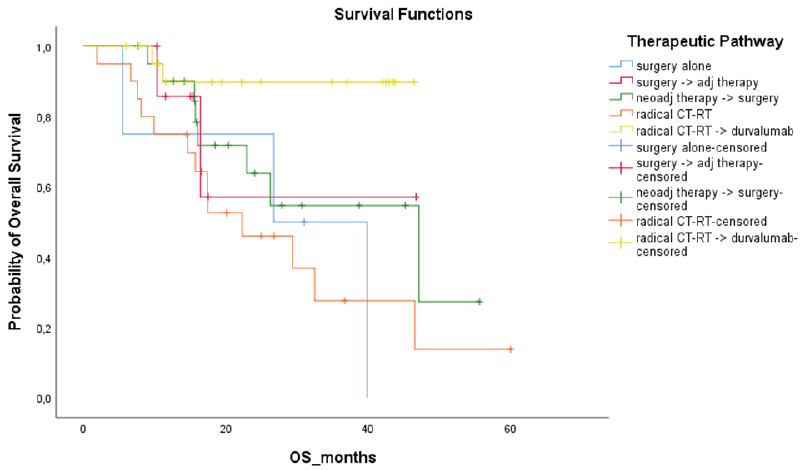
Figure 15. Kaplan–Meier curves of estimated overall survival according to treatment modality in stage IIIB-C patients treated after 2018. CT-RT, chemo-radiation therapy.